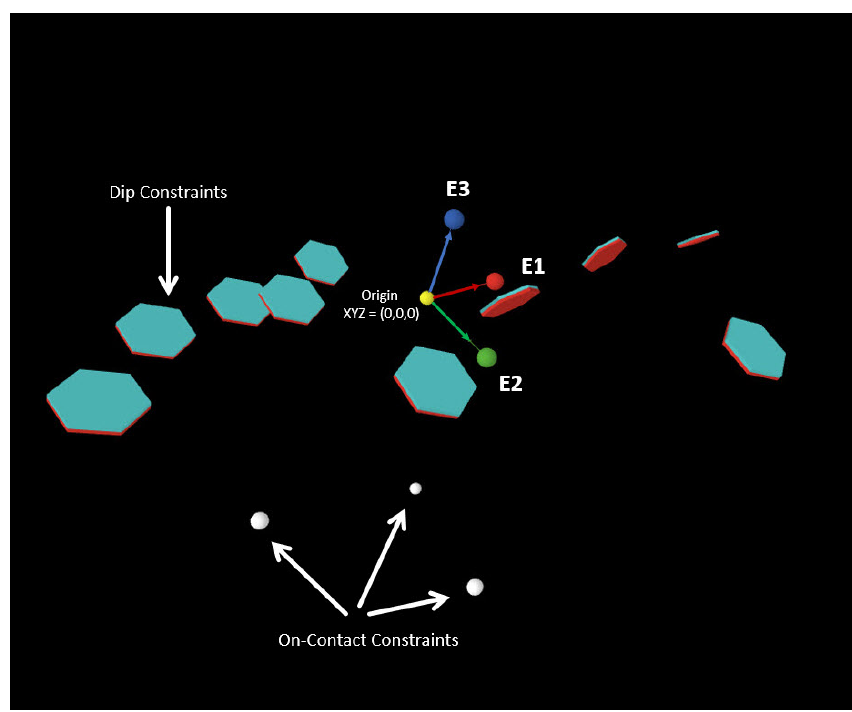
Figure 6. Input data constraints. On-contact (white spheres) and dip (where blue thin hexagonal prisms denote upright, and red thin hexagonal prisms denote the down direction) constraints representing simple 3D geological data constraints. The arrows at the origin indicate the calculated orthogonal unit eigenvector directions for the structural data. Depending on the scenario, the structural agents will do a SLERP interpolation (De Paor, 1995, 1996; Shoemake, 1985; Hamilton, 1844) using a rotation vector from the major global eigenvector axis to simulate the behaviour of bedding rotation due to near-coaxial folding (Woodcock, 1977). For the specific calculations used in each program, see comments in the source code at GitHub open-source website at https://github.com/Loop3D/GeoSwarm (last access: 1 October 2021) (https://doi.org/10.5281/zenodo.4634021, de Kemp, 2021); the reader is referred to Davis and Titus (2017, and the Appendix therein) and Adamuszek et al. (2011) for a thorough review of structural data computations. A summary of the quaternion rotation math is given